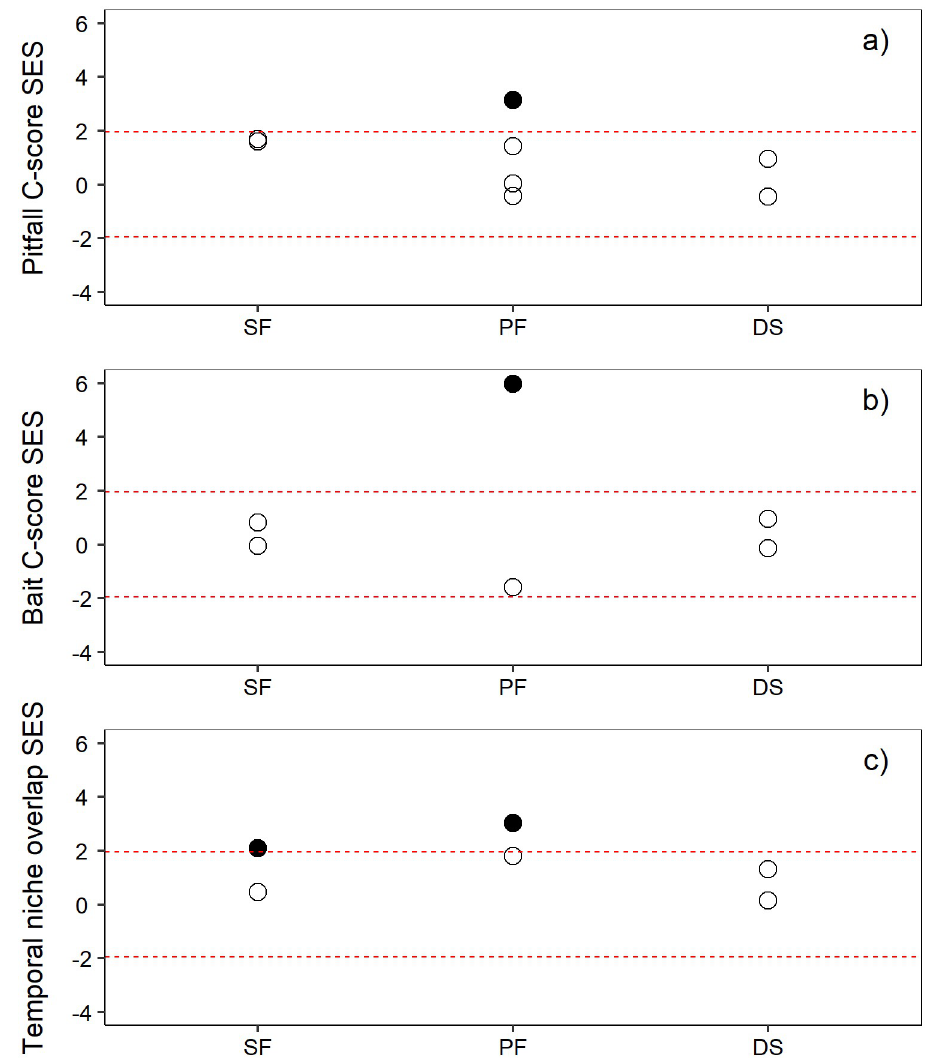
Fig 2. C-score standardized effect size (SES) values at each study habitat. (SF: Savin forest, PF: Pine forest, DS: Dry scrubland) from the C-score of (a) pitfall catches and (b) bait observations, and (c) temporal niche overlap. The dotted lines represent 1.96 standard deviation, the approximate level of statistical significance (p < 0.05). Thus, the larger standardized C-scores (filled circle), the less co-occurrence compared with a randomly assembled community, while values within the dotted lines (open circle) correspond to a random pattern of